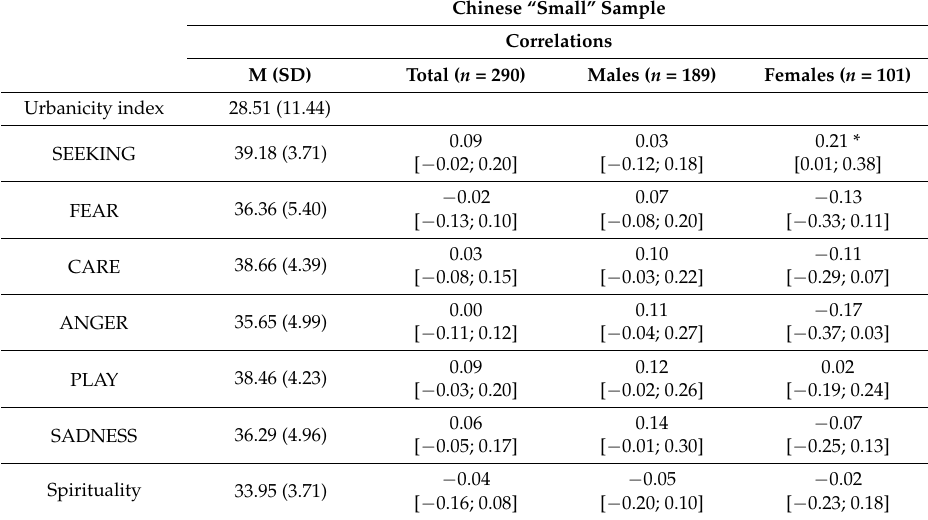
Table 6. Means (SDs) and partial correlations (controlled for age) and 95% confidence intervals between the urbanicity index and the ANPS Scales in the “small” Chinese